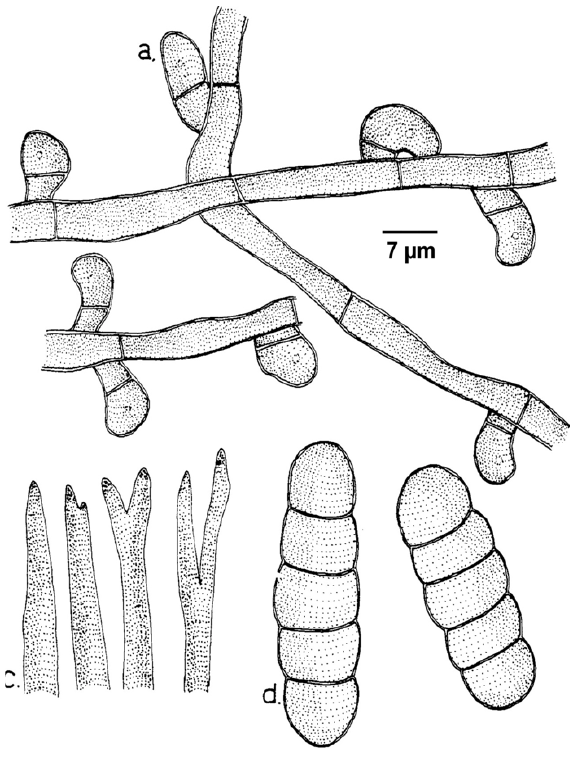
Figure 127. Meliola zanthoxyli a - Appressorium; b - Phialide; c - Apical portion of mycelial setae; d - Ascospores